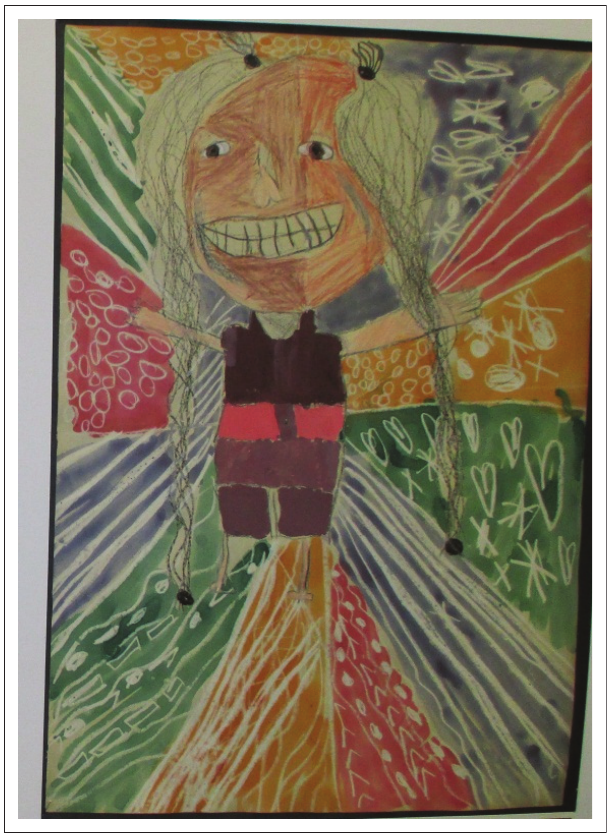
FIGURE 4: Myself playing